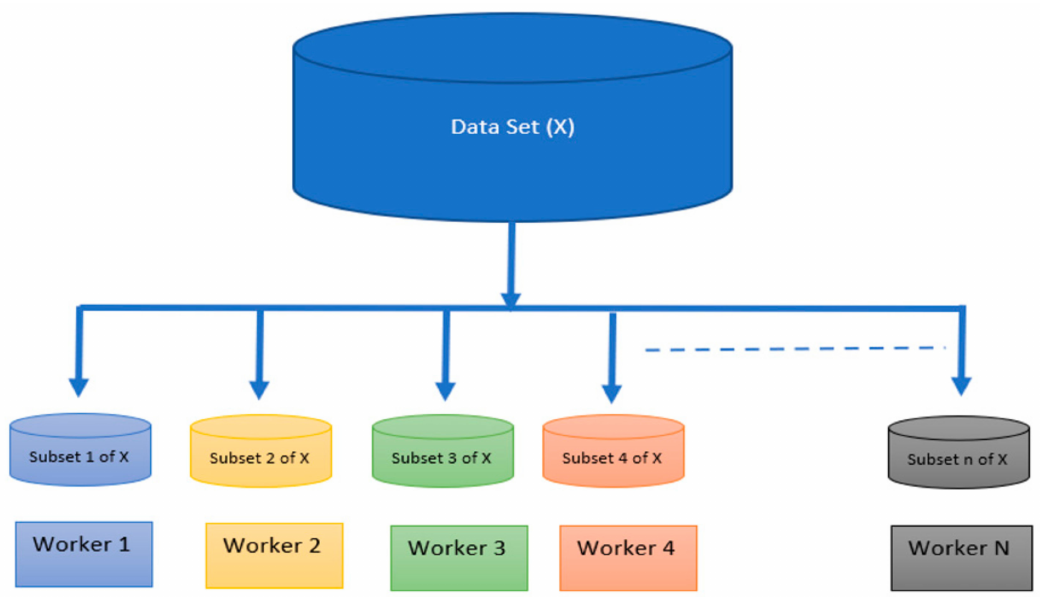
Figure 2. Splitting a dataset among workers in shared and distributed memory systems.